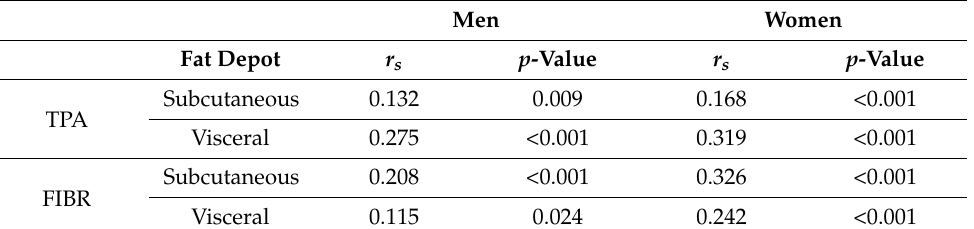
Table 2. Correlation between baseline fat volumes and levels of baseline TPA and FIBR for all DPP participants.